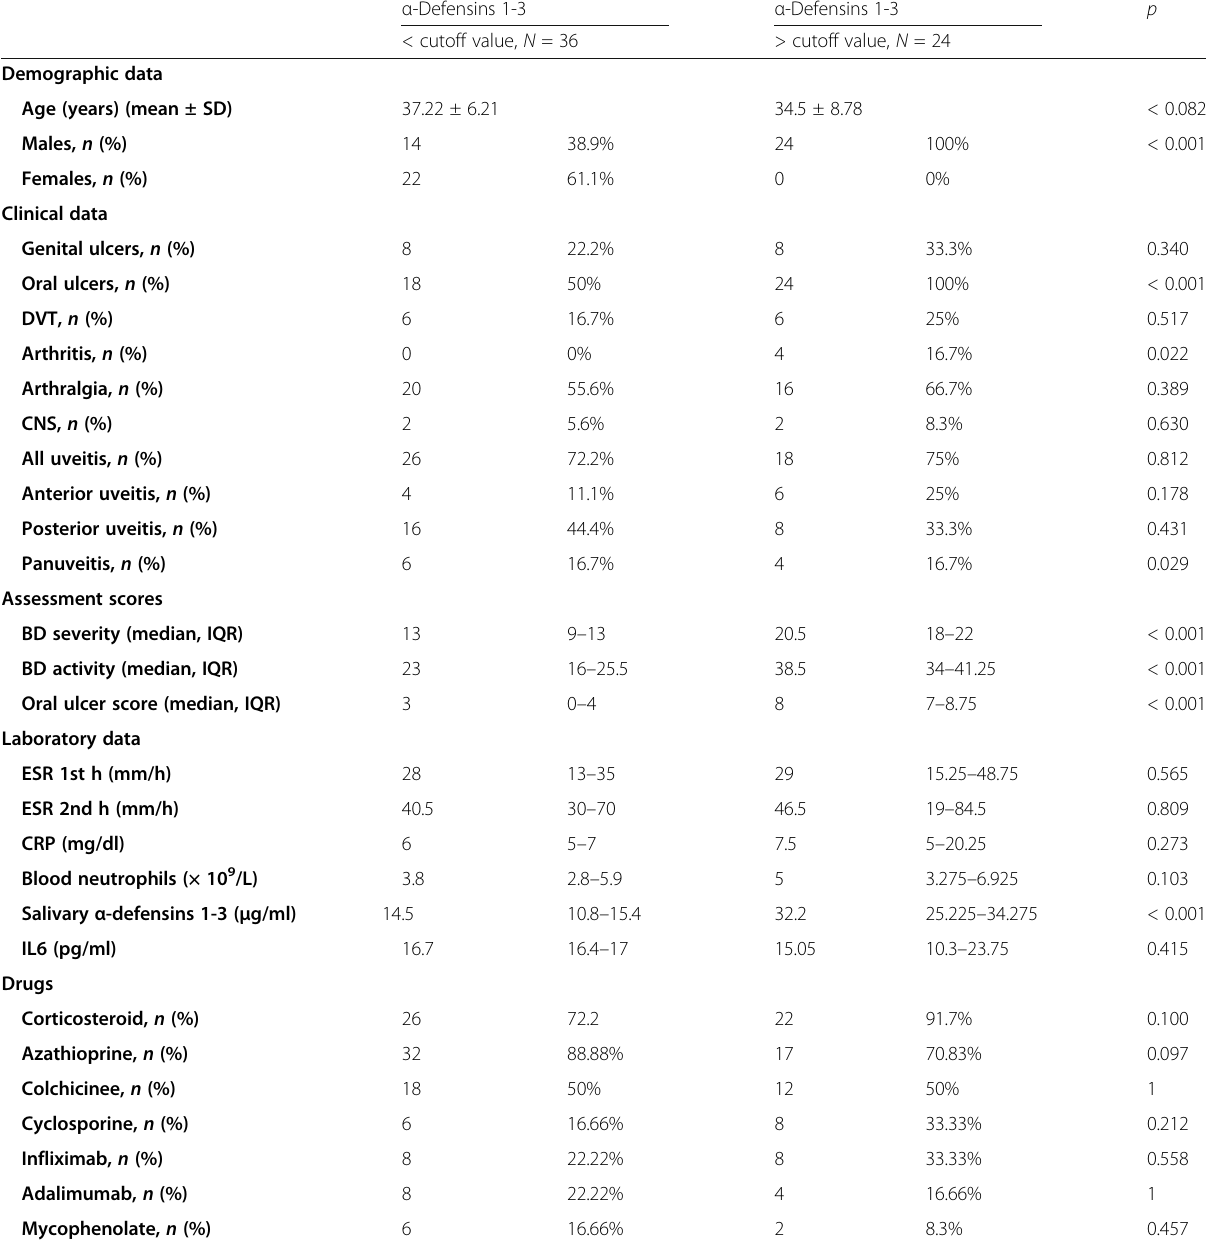
Table 1 Comparison of demographic data, clinical symptoms, clinical scores and laboratory investigations according to serum α - defensins 1-3 cutoff